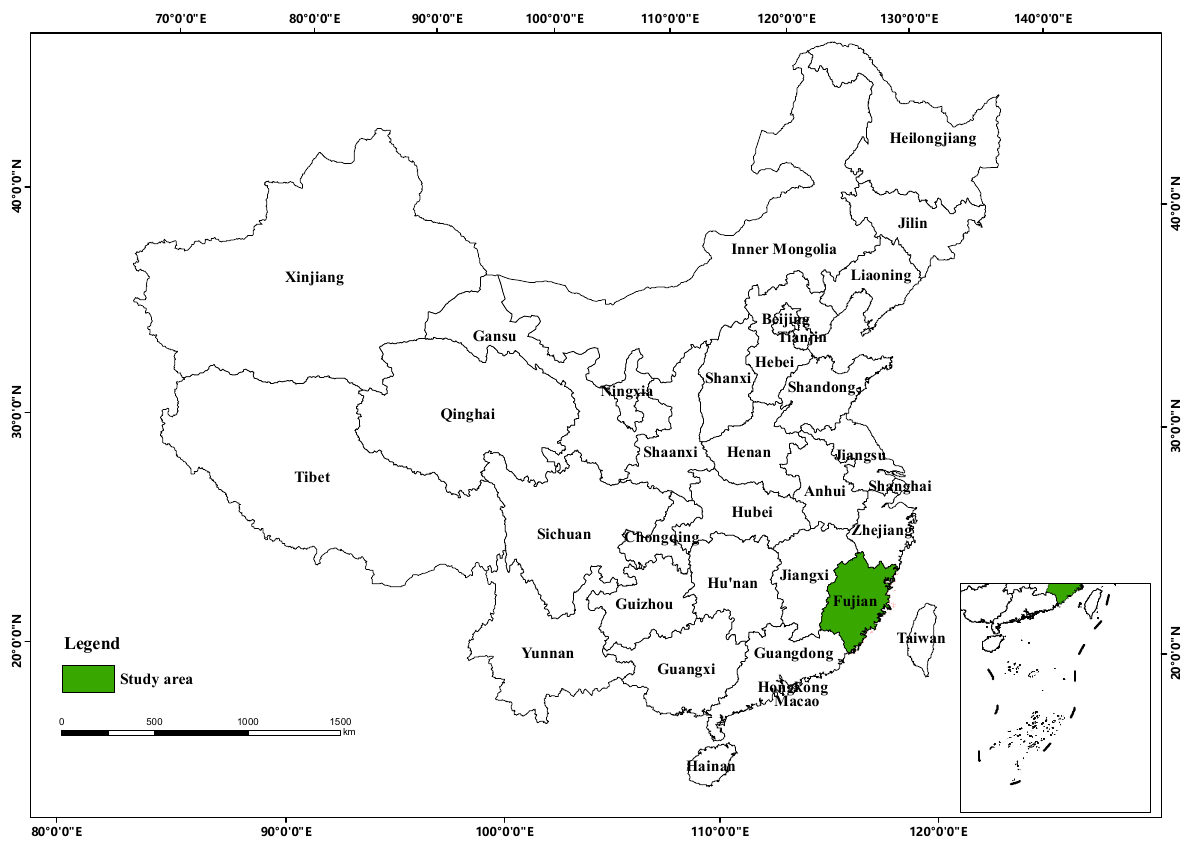
Figure 1. Location of Fujian province in China.